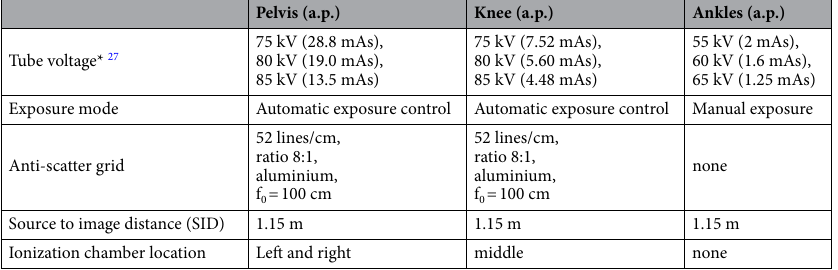
Table 4. Examination protocols. *Tube voltage on the DX-D 600 system was measured with a calibrated non- invasive multimeter prior to the measurements for 75 kV nominal and an accuracy of 3.1%. This is within the typical range of this type of DDR system and within the assumptions for the used